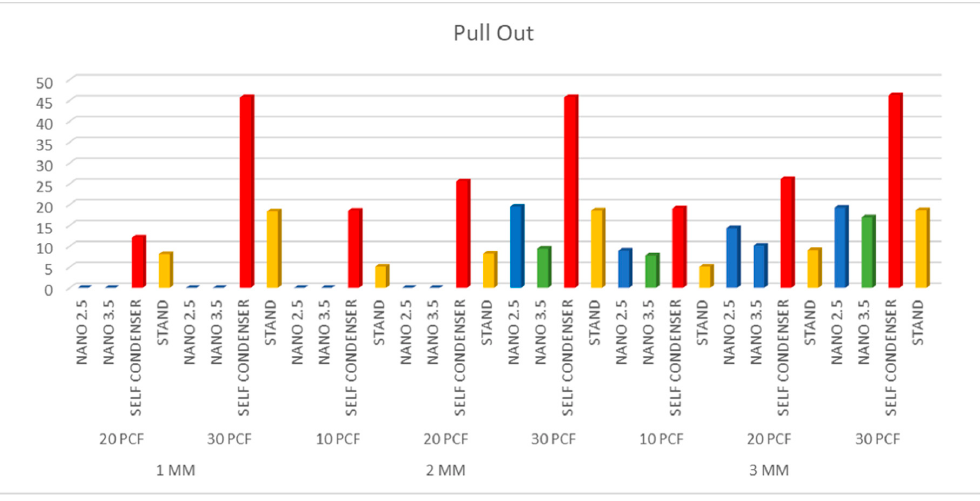
Figure 4. Results of the investigation of pull-out torque. The self-condenser implant showed the highest ratio of stability.